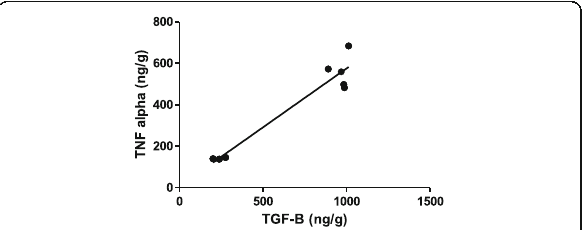
Fig. 2 Correlation between TNF- α and TGF- β (ng/g); r =0.9673, p